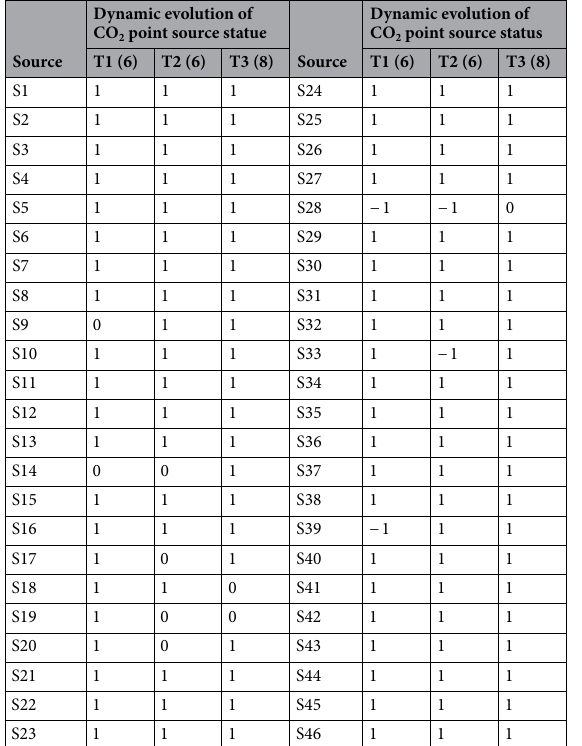
Table 7. Input data for different scenarios of evolution of CO 2 point sources for the I-WEST case study (1 indicates open, 0 indicates closed, and − 1 indicates unknown status).